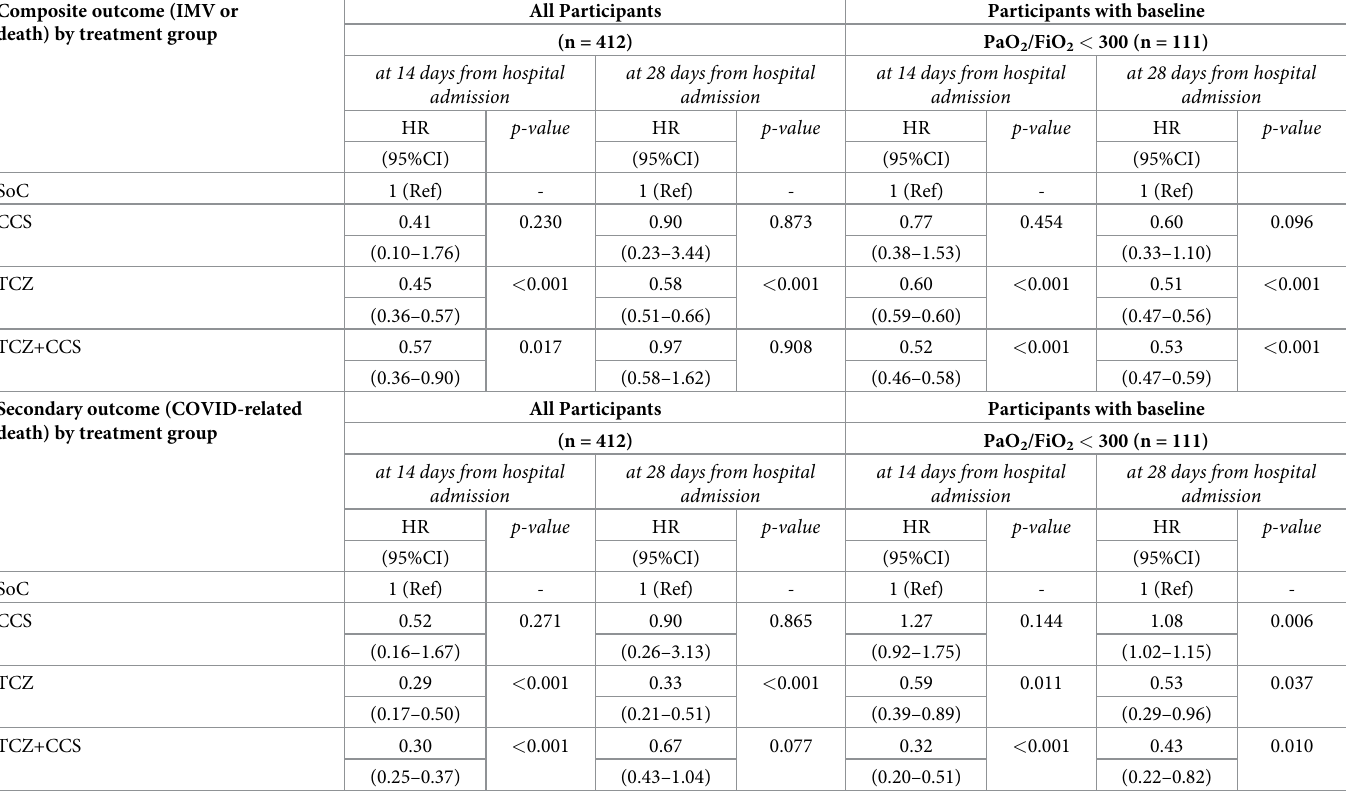
Table 5. Multivariate analysis 1 composite primary and secondary outcomes at day-14 & day-28 from hospital admission among all population and in subgroups by disease severity. Composite outcome (IMV or death) by treatment group